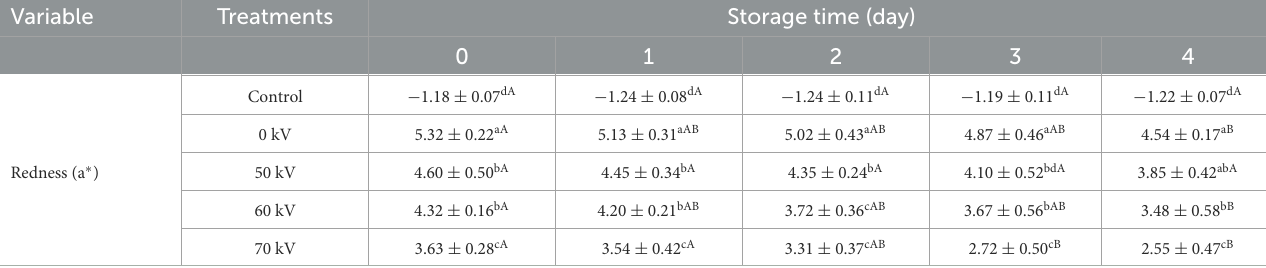
TABLE 1 Changes in instrumental redness of washed pork muscle with added Mb treated by DBD-CP at different voltages during storage (4 ◦ C for 4 days). Variable Treatments